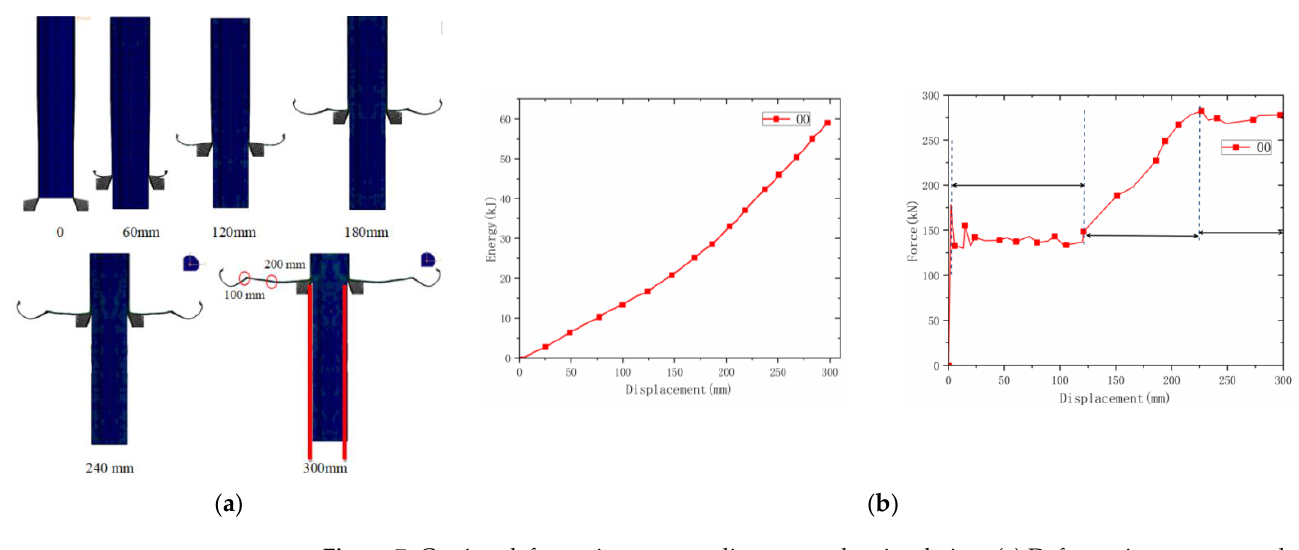
Figure 7. Cutting deformation process diagram under simulation. ( a ) Deformation process under simulation; ( b ) displacement force and energy curve.